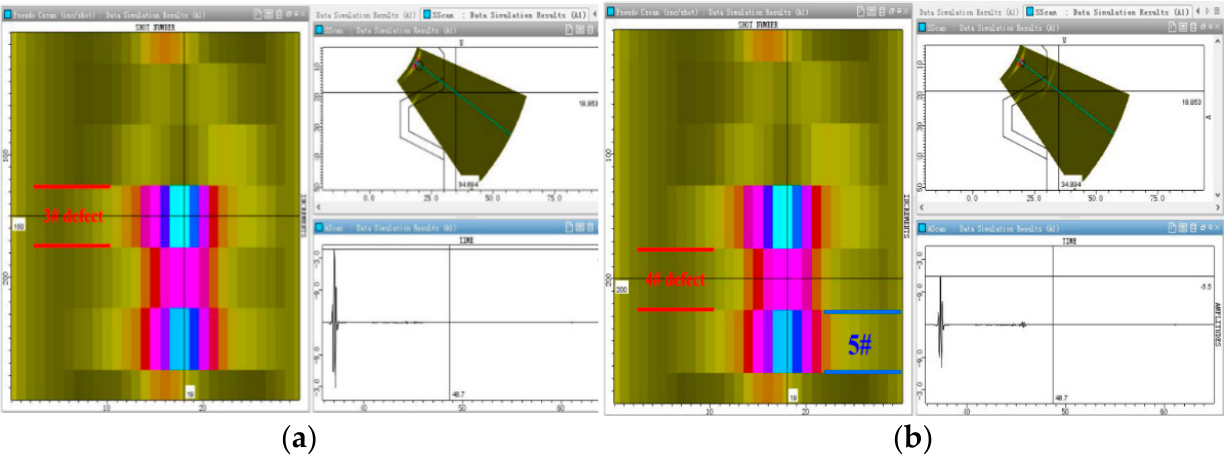
Figure 13. Simulation analysis of signal echoes of slag inclusions and porosity defects. ( a ) Defect 3#. ( b ) Defect 4#.